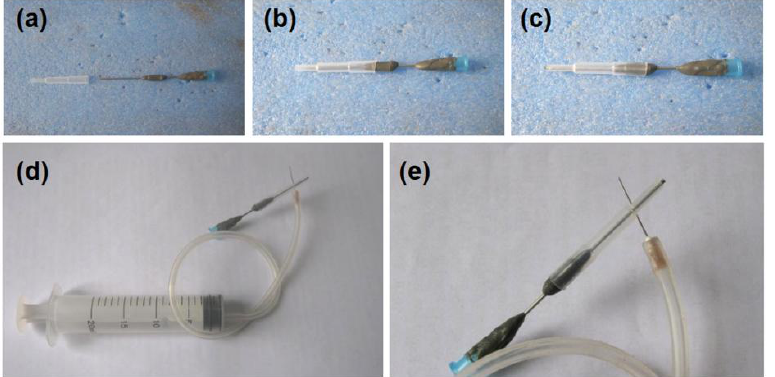
Figure 2. The preparation of the detachable concentric spinneret: ( a – c ) shows its formation by connecting a PE tubing with a traditional needle; ( d , e ) show the organization of syringes for conducting the working processes.